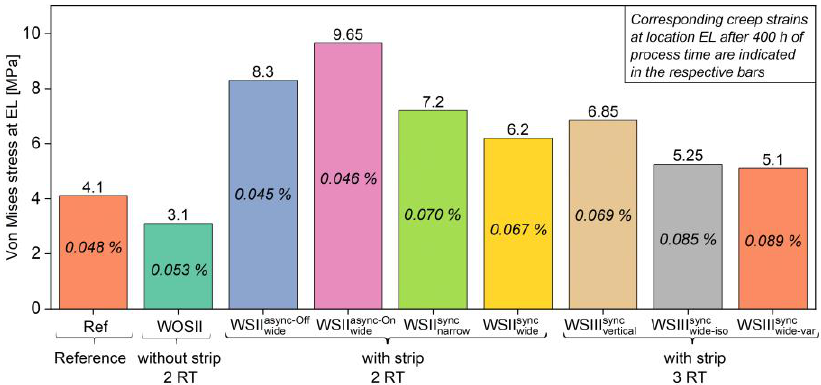
Figure 11. Results of burner firing operations: ( a ) temperature-time-cycle and ( b ) creep strain at location EL.